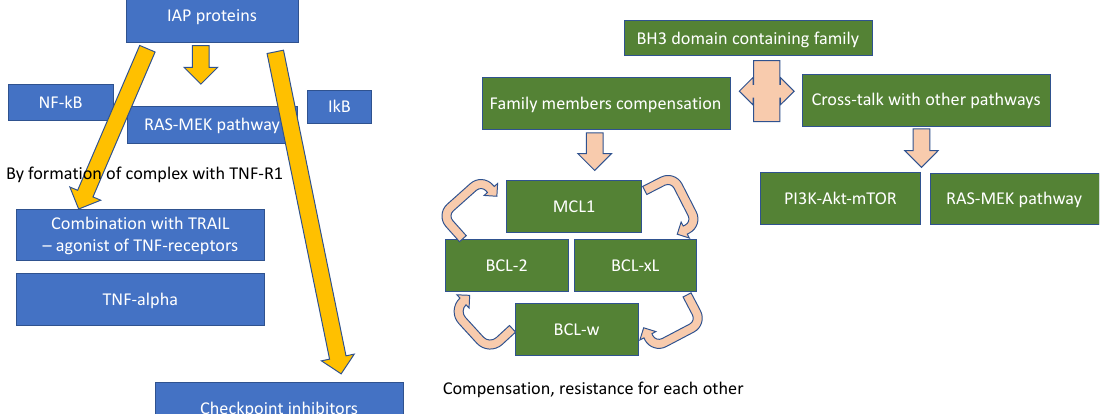
Fig.3. Combination strategy based on reported pathway that interacts with apoptosis regulating proteins.